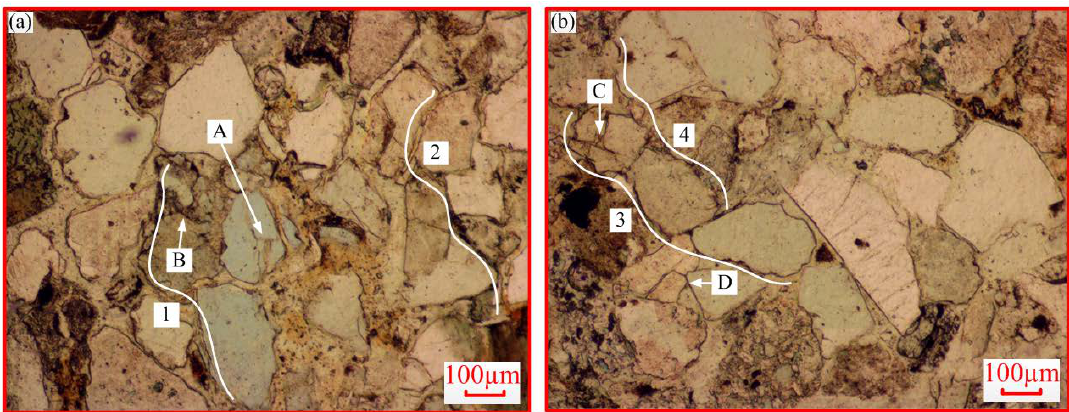
Figure 9. Thin sections obtained along different directions after the conventional uniaxial compressive strength (UCS) tests. ( a ) Thin section in the lateral direction and ( b ) thin section in the axial direction. The numbers 1–4 near the lines stand for the number of cracks seen in the microscopy.